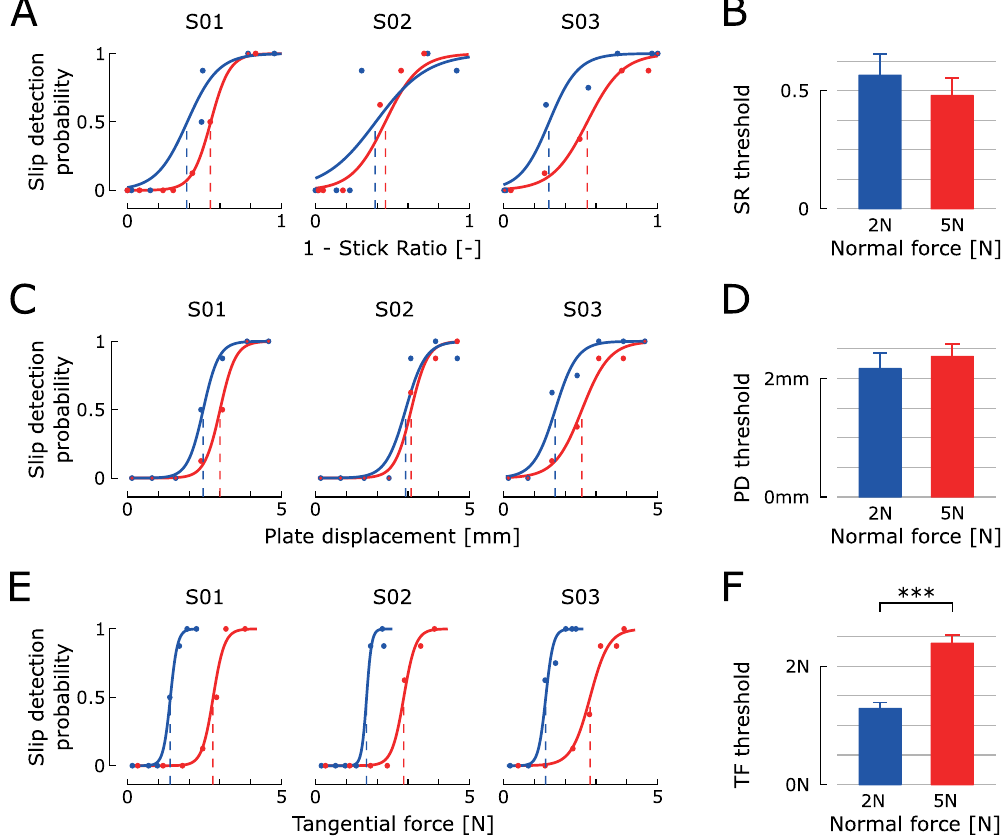
Figure 2. Experiment 1: Slip detection thresholds on bare glass with two NF levels. Subjects detected fingertip slip before full slip and could not rely on TF to detect slip. Slip detection responses from three typical subjects are plotted against 1 – SR, PD, and TF in panels A, C and E, respectively. Psychometric curves were fitted on subjects’ answers from the two experimental conditions (NF = 2 N, blue, vs. 5N, red), which